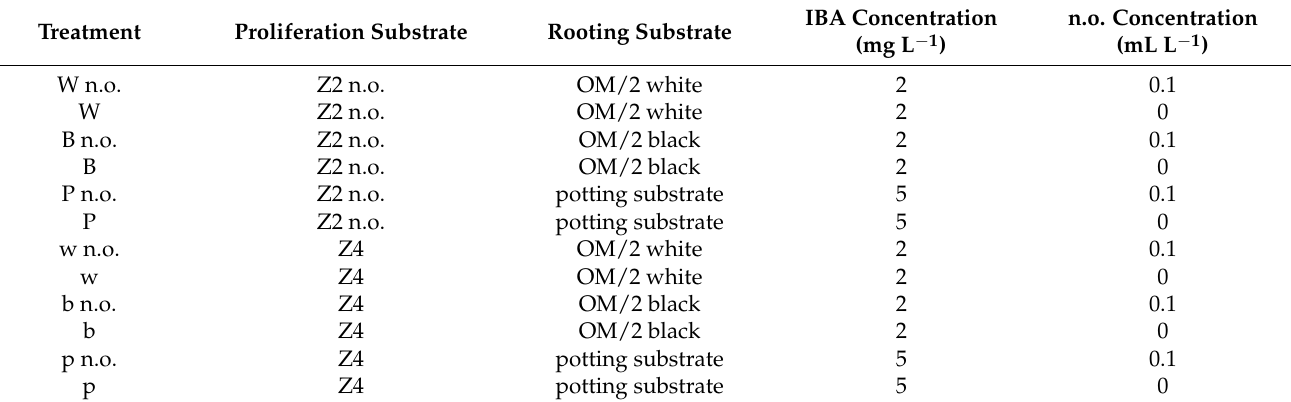
Table 5. Substrates used for the rooting phase and their characteristics in terms of IBA concentration and neem oil (n.o.)